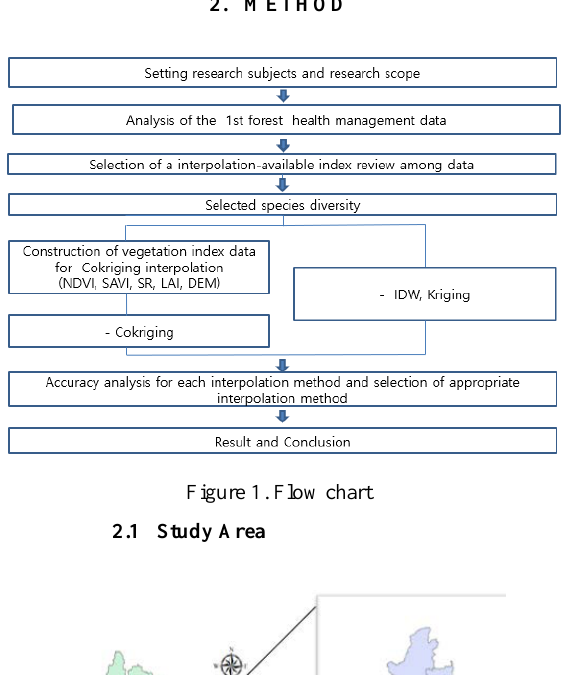
Figure 1. Flow chart